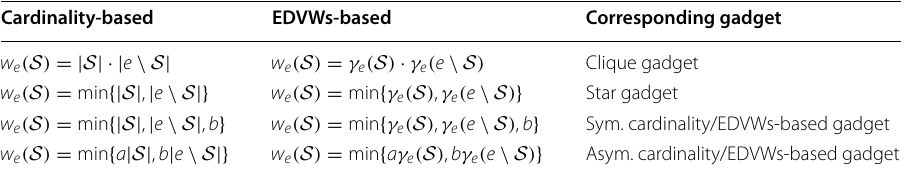
Table 1 Examples of cardinality-based and EDVWs-based splitting functions and their corresponding gadgets where S is a subset of the hyperedge e and a , b are positive constants Cardinality-based EDVWs-based Corresponding gadget w e ( S ) = | S | · | e \ S | w e ( S ) = γ e ( S ) · γ e ( e \ S ) Clique gadget w e ( S ) = min {| S | , | e \ S |} w e ( S ) = min { γ e ( S ) , γ e ( e \ S ) } Star gadget w e ( S ) = min {| S | , | e \ S | , b } w e ( S ) = min { γ e ( S ) , γ e ( e \ S ) , b } Sym. cardinality/EDVWs-based gadget w e ( S ) = min { a | S | , b | e \ S |} w e ( S ) = min { a γ e ( S ) , b γ e ( e \ S ) } Asym. cardinality/EDVWs-based